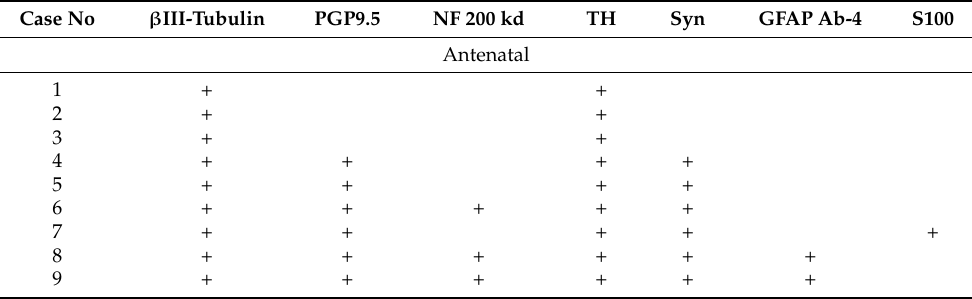
Table 1. Expression of markers in different samples of the human carotid